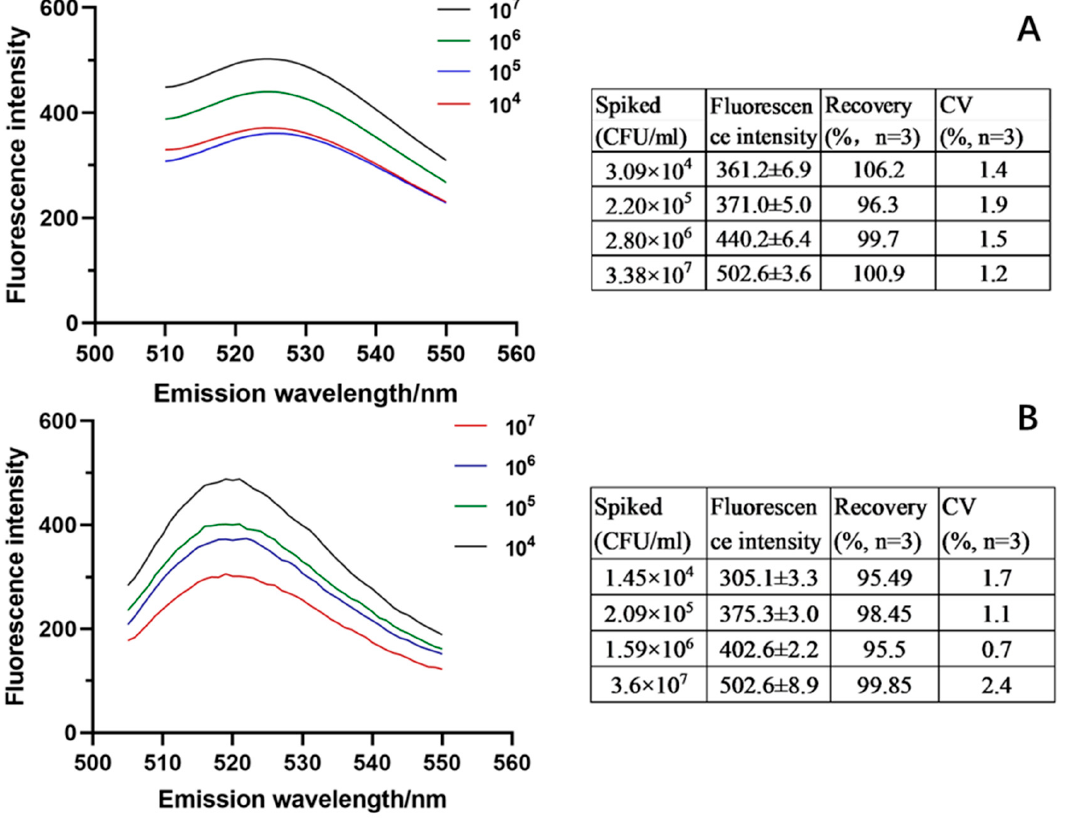
Figure 9. Results of paper@epoxy@PEI-DFFPBA-based fluorescence analysis of S. aureus in milk ( A ) and yogurt ( B )